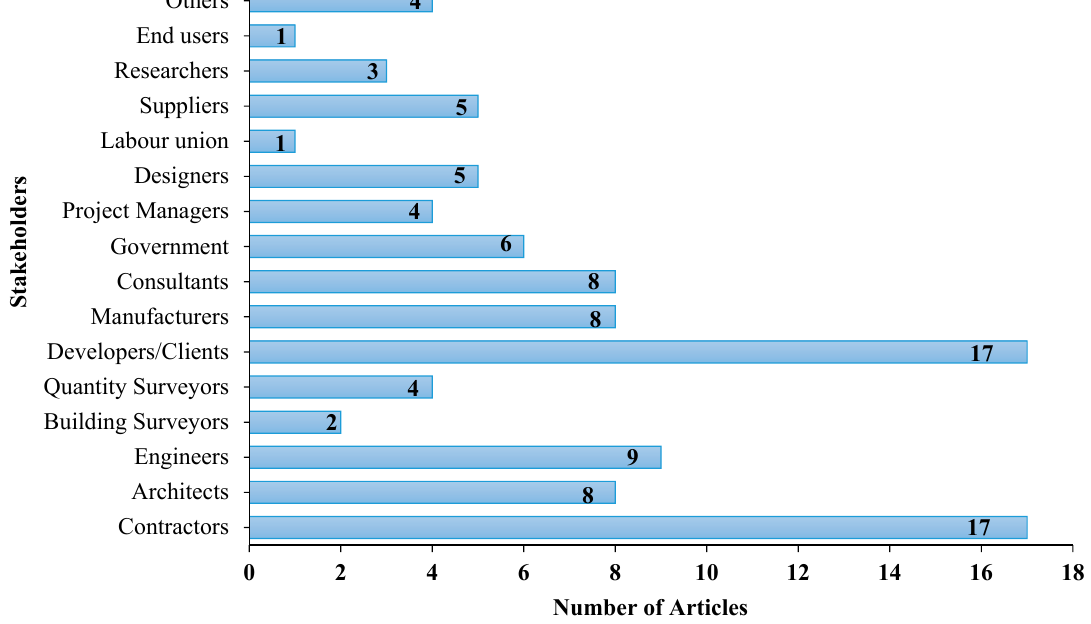
Figure 5. Primary stakeholders and actors in studies of the drivers of OSC.